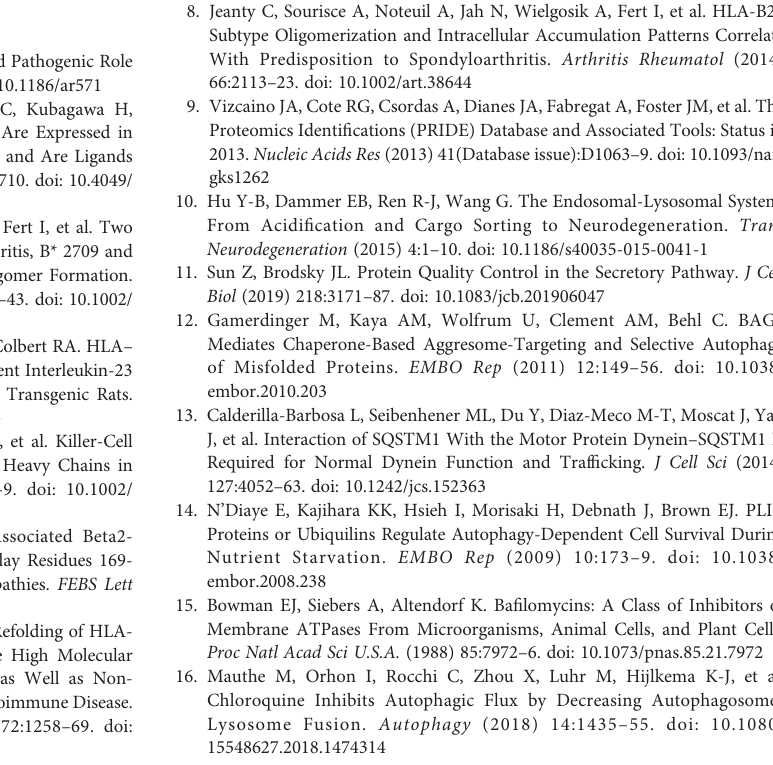
Supplementary Figure 1 | Boxplots representing abundance distribution of proteins in cells expressing B*2704 (blue colour) and B*2709 (orange colour) (A) , made using Proteome Discoverer (version 2.4). Principal Component Analysis (PCA) carried out using R software (version 3.4.1) (B) . Supplementary Figure 2 | Protein – protein interaction analysis (conducted by the String database, version 11.0) of 261 proteins found to be upregulated in cells expressing B*2704 (A) . The proteins related to Unfolded Protein Response (B) and autophagy pathway (C) are also shown. Supplementary Figure 3 | Protein – protein interaction analysis (conducted by the String database, version11.0) of 174 proteins found to be upregulated in cells expressing B*2709 (A) . The proteins related to vesicle transport from ER to Golgi are also shown (B) . Supplementary Figure 4 | Western blot corresponding to non-reducing SDS- PAGE gel electrophoresis of lysates derived from cells transfected with B*2704 and B*2709 under conditions of absence and presence of CQ. Blots were probed with HC 10 antibody to analyze the oligomeric species. Images were taken under short and long exposures to better highlight the presence of differently oligomerized species in each case. Supplementary Figure 5 | Real Time PCR was carried out to evaluate the expression of UPR markers for non-transfected cells (H1299) and transfected cells expressing B*2704 and B*2709, following treatment with CQ (50 m M) for 12h. Supplementary Figure 6 | Immuno fl uorescence staining was performed for H1299 cells (A) , cells transfected with B*2704 (B) and B*2709 ( (C) subtypes by confocal microscopy using anti-LC3 and anti-p62 antibody (probed with anti-rabbit Alexa Fluor 568) (red). Nuclear staining was done using DAPI (Blue). Supplementary Figure 7 | Stable transfectants of pEGFP-HLA-B27 subtypes (B*2704 and B*2709), treated with (+) or without (-) the proteasomal inhibitor, MG132, and probed with anti-phospho-eIF2 a